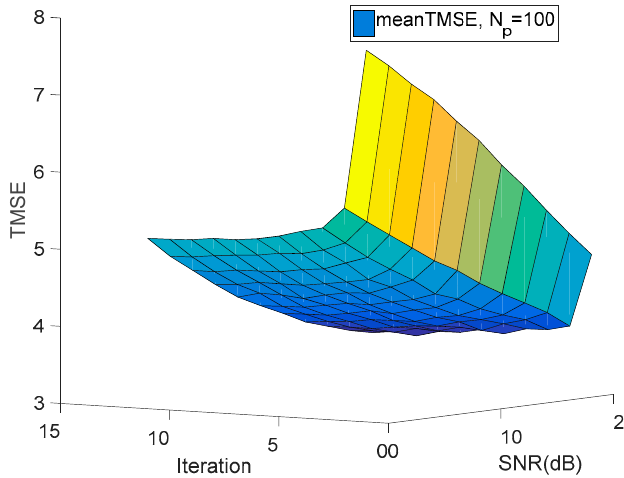
Figure 5. The TMSE versus the number of iterations and SNR.